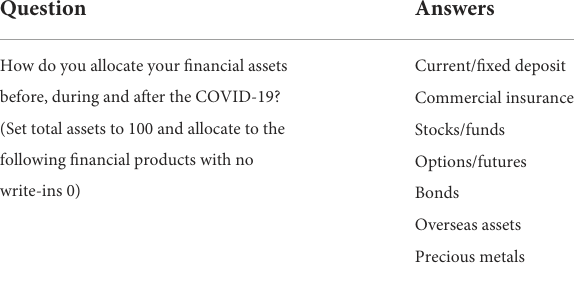
TABLE 1 Some questions in the questionnaire. TABLE 2 Sociodemographic characteristics of participants ( N =